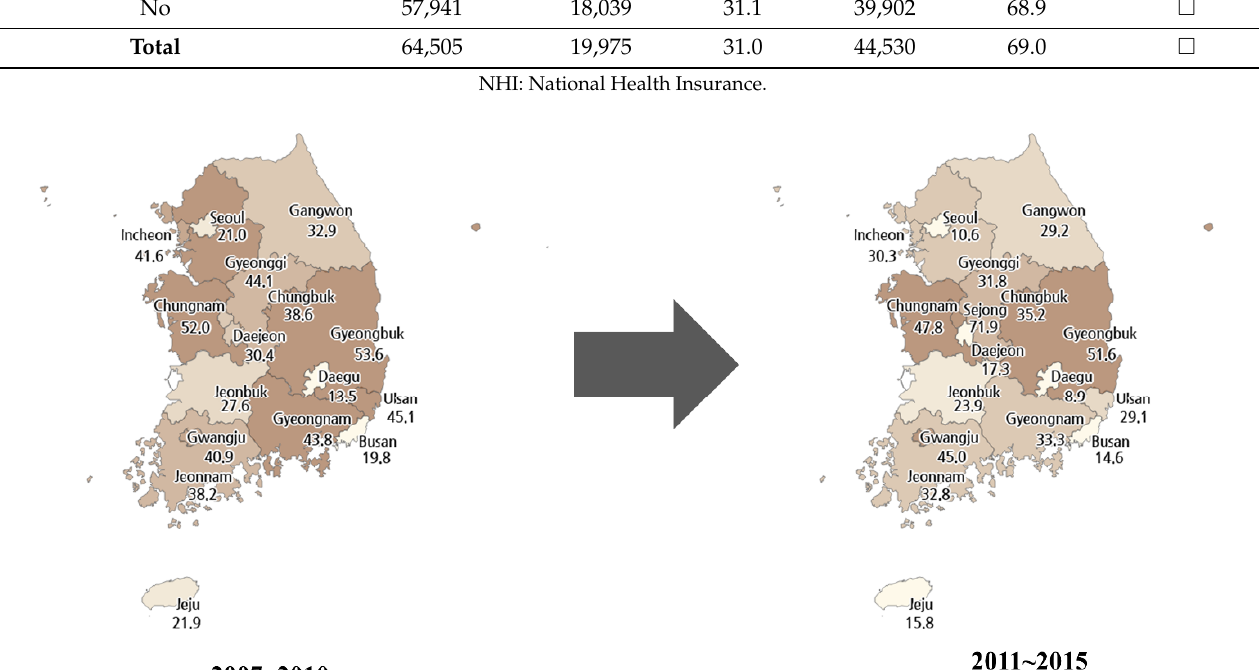
Figure 1. The difference of patient’s residing area and major treatment area.